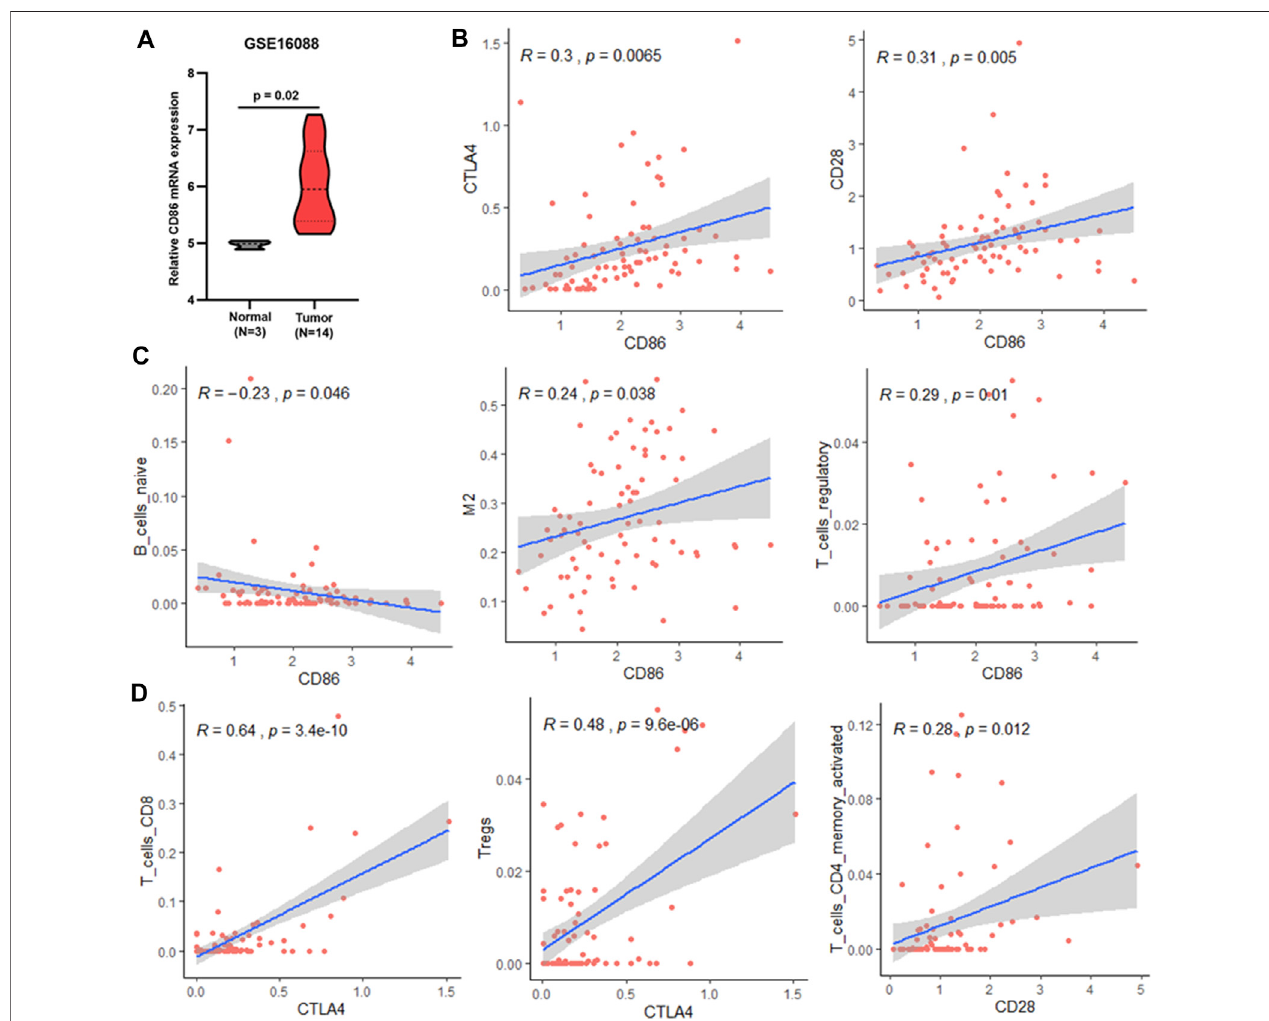
FIGURE 7 | Association between CD86 and TIICs. (A) CD86 expression in normal bone and osteosarcoma tissues (GSE16088). (B) Correlation between CD86 expressionandCTLA4orCD28expressioninvalidationcohort(TARGET). (C) AssociationsbetweenCD86expressionandin fi ltrationofnaïveB-cells,M2macrophages, and regulatory T-cells in the validation cohort (TARGET). (D) Correlation between CTLA4 or CD28 expression and in fi ltration of CD8 T-cells, Tregs, and memory CD4 T-cells in the validation cohort (TARGET).